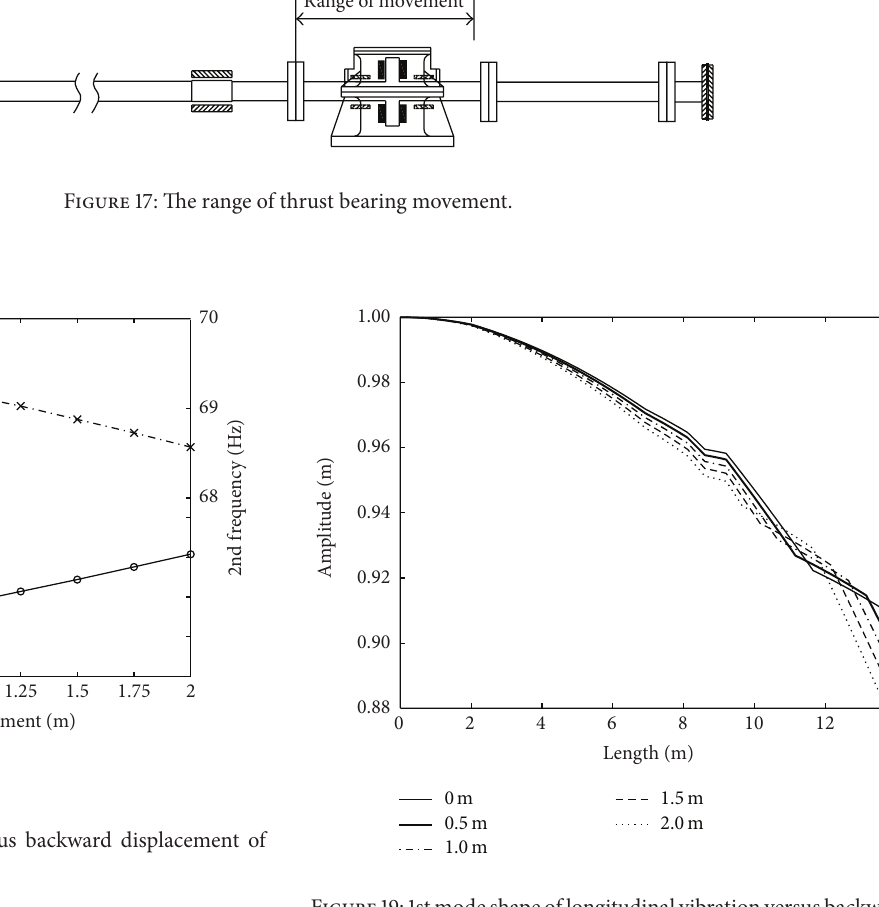
Figure 19: 1st mode shape of longitudinal vibration versus backward displacement of thrust